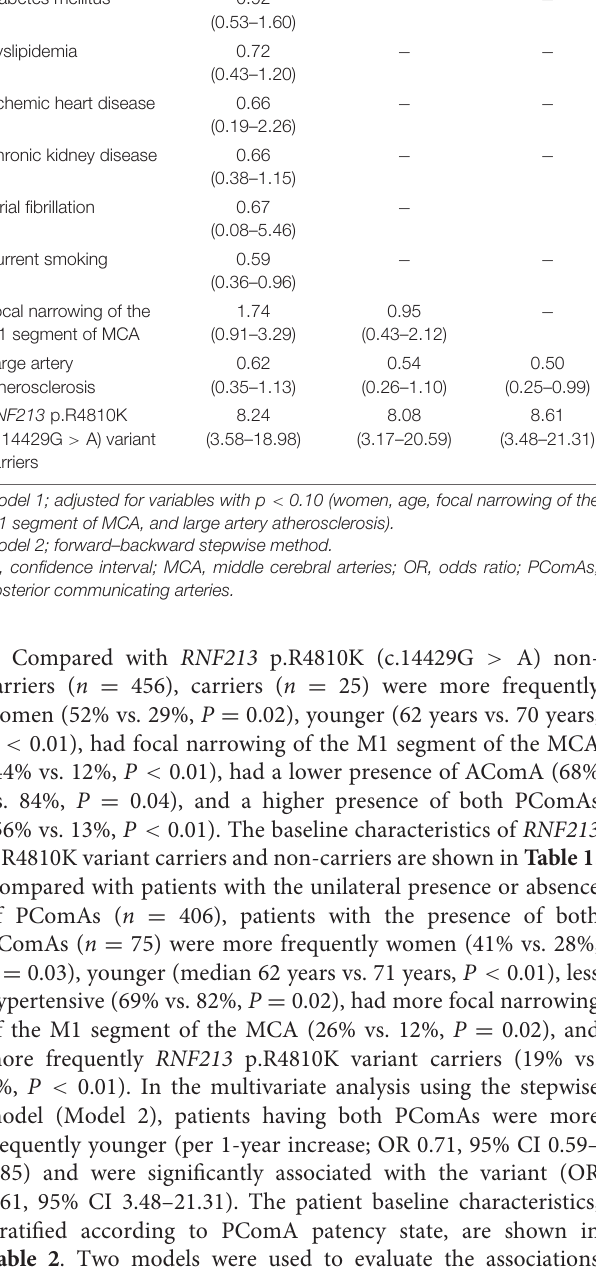
Table 2 . Two models were used to evaluate the associations between PComAs patency state and the factors shown in Table 3